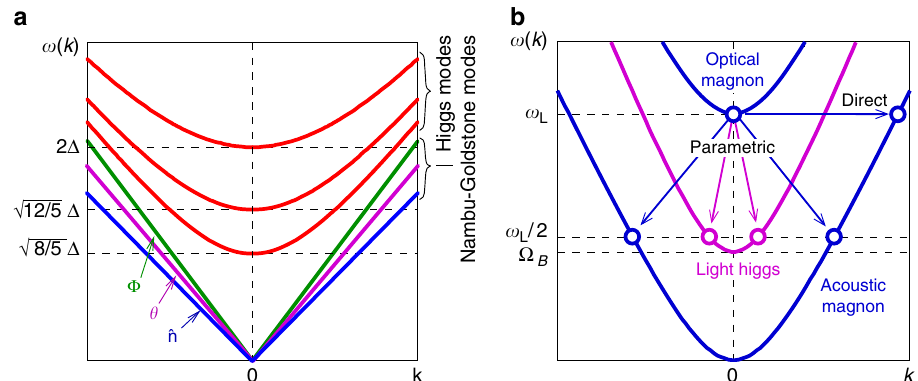
Figure 1 | Illustration of collective-mode spectra in 3 He-B. ( a ) Modes at high-energy scale ( o B D B 100MHz). From top to bottom there are six separate branches. Three red lines show heavy Higgs modes: four degenerate pair-breaking modes with the gap 2 D , five imaginary squashing modes with the gap ffiffiffiffiffiffiffiffiffiffi 12 = 5 p D and five real squashing modes with the gap ffiffiffiffiffiffiffiffi 8 = 5 p D . Nambu-Goldstone modes include a sound mode (propagating oscillations of F ), a spin-wave mode that corresponds to propagating oscillations of y , two spin-wave modes that correspond to propagating oscillations of ^ n . These modes are gapless at the high-energy scale and have different propagation velocities c . ( b ) Spin-wave modes at low-energy scale ( o B 10 (cid:3) 3 D B 100kHz). Because of spin–orbit interaction, the y mode acquires a small gap O B oo D and becomes a light Higgs boson. Two ^n modes are split by the magnetic field into optical and acoustic magnons. Arrows indicate decay channels observed in our